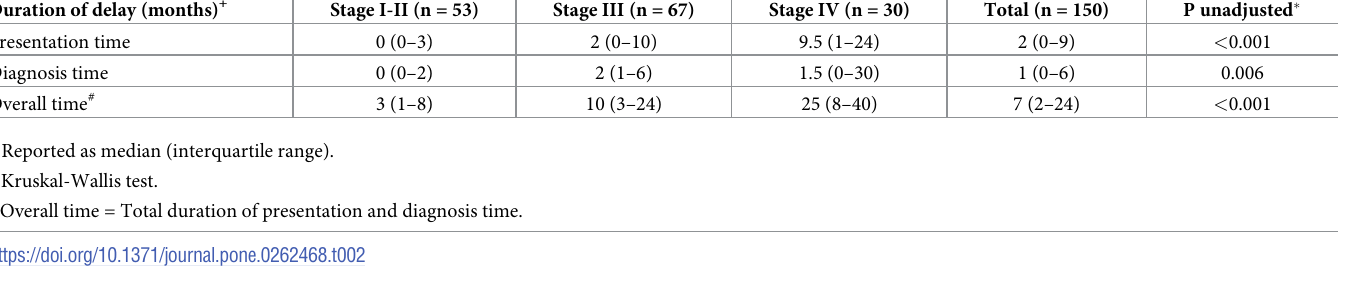
Table 2. Median presentation, diagnosis, and overall delay for all participants (n = 150) by stage at diagnosis. Duration of delay (months)